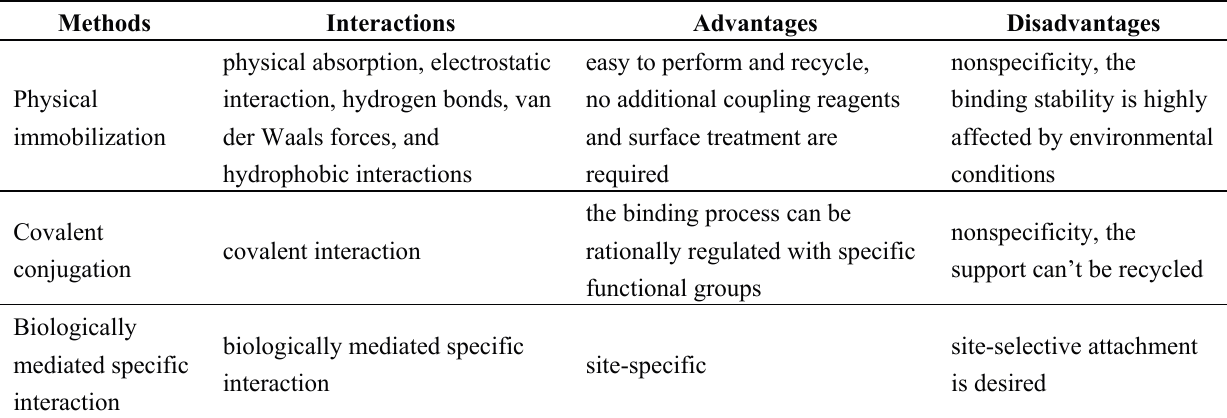
Table 2. Comparation between different immobilization